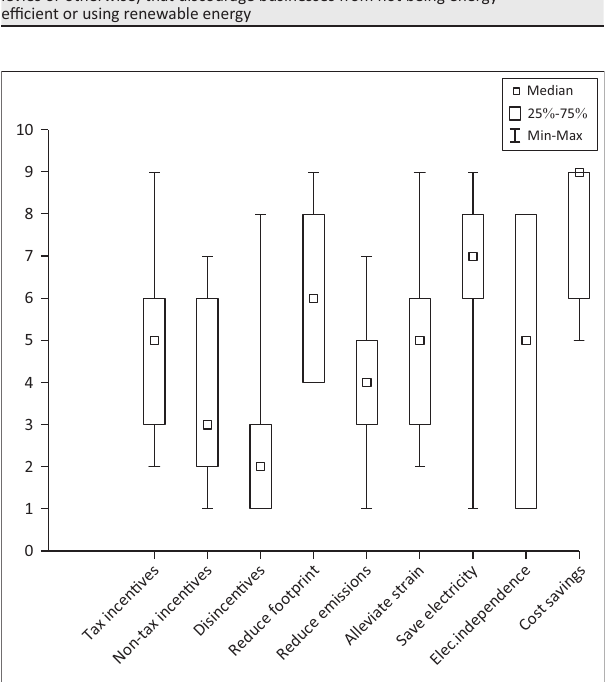
FIGURE 1: Statistical presentation of ranks of